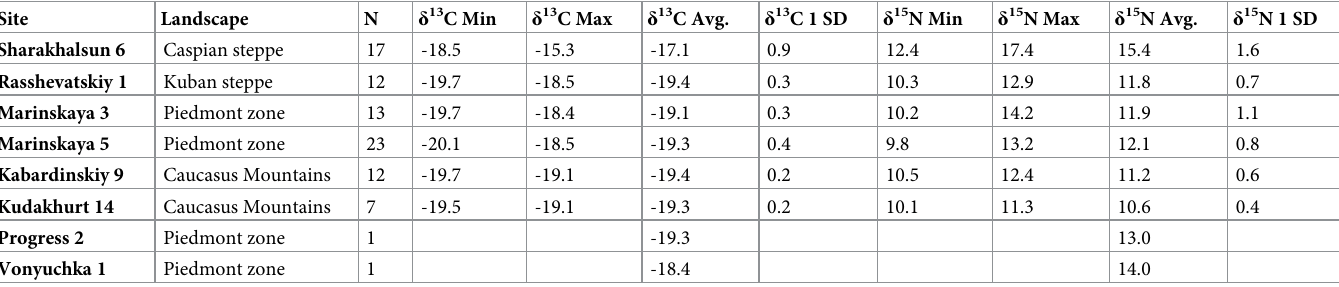
Table 3. Summary statistics of the δ 13 C and δ 15 N values of the human bone collagen investigated in this